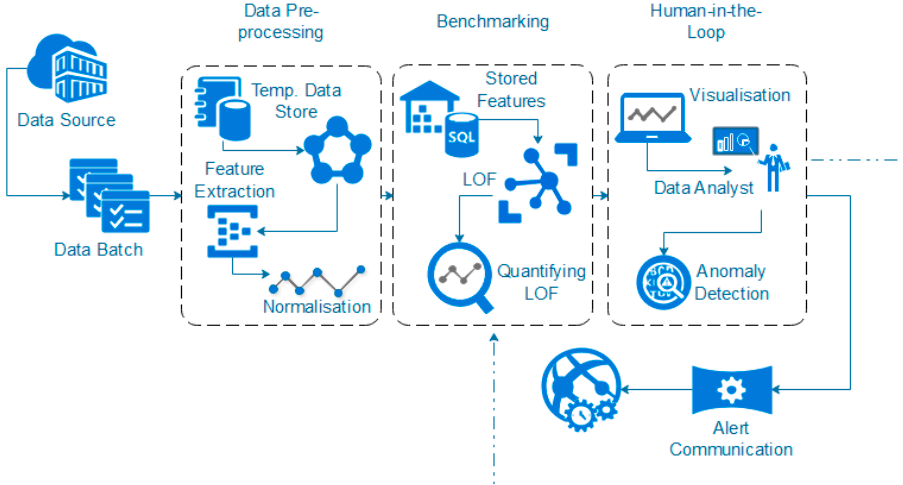
Figure 3. System methodology.